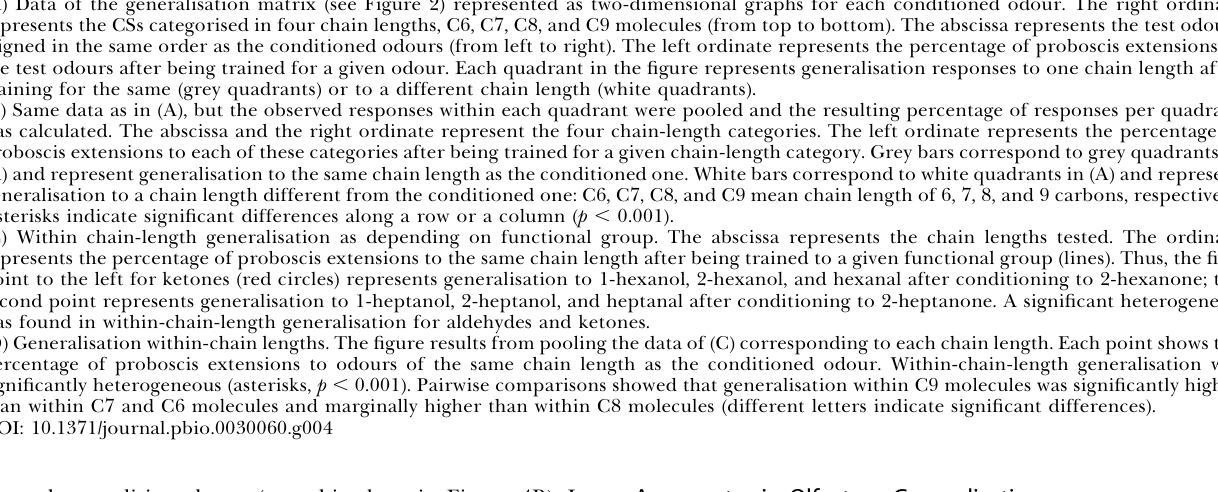
general, responses to molecules with different chain lengths followed a clear decreasing gradient, depending on the difference in the number of carbon atoms between the molecules considered (see Figure 4B; all horizontal and vertical comparisons were significant, v 2 . 16.3, df = 3, p , 0.001 in all eight cases). For instance, when conditioned to a C9 molecule (see Figure 4B, fourth row), bees responded in 53%, 31%, and 23% of the cases to C8, C7, and C6 molecules, respectively, while they responded to C9 molecules in 67% of the cases. This gradient was also evident when generalisation took place between functional groups: for instance, after training with 2-nonanol (see Figure 3A, second row), the response of bees to odours of different functional groups (solid lines in white boxes) always followed a similar decreasing tendency with the same (C9) or similar (C8) chain length on top.